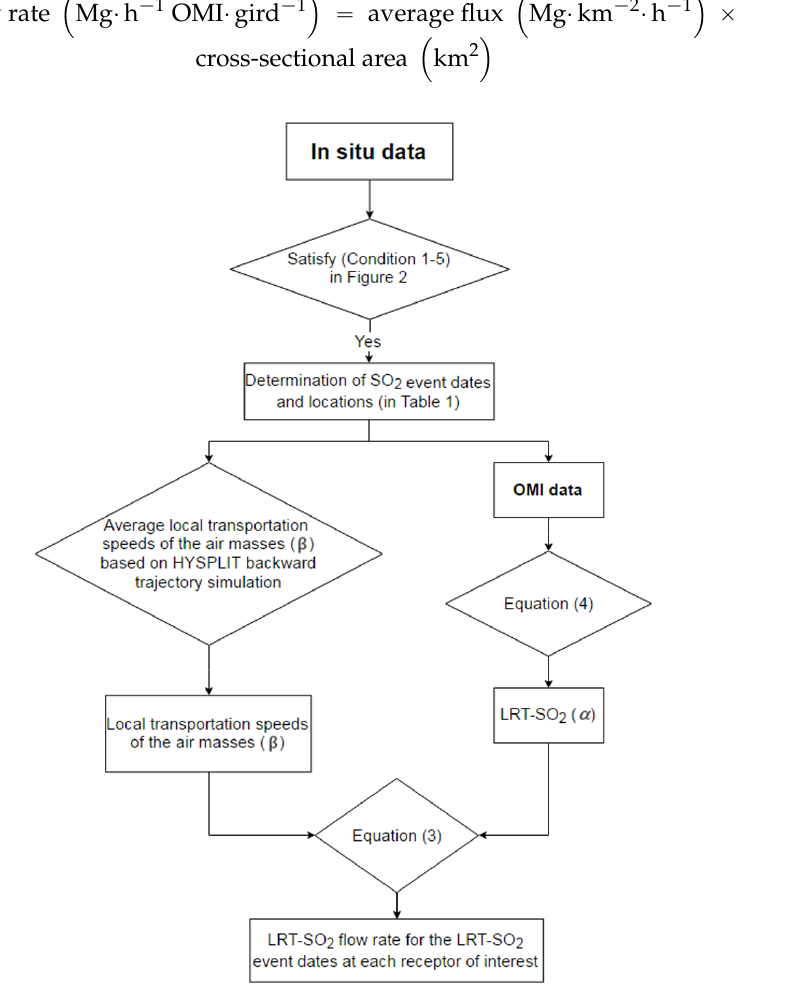
Figure 3. Flow rate of the calculation method for the LRT-SO 2 event dates at each receptor location of interest.